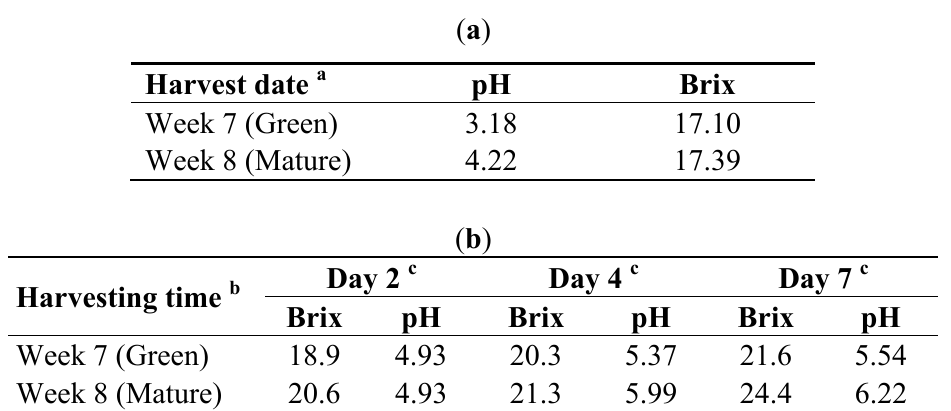
Table 5. (a) pH and Brix levels for four different maturity and ripeness levels of Harumanis; (b) Brix and pH for four different maturity and ripeness levels that were harvested on two different